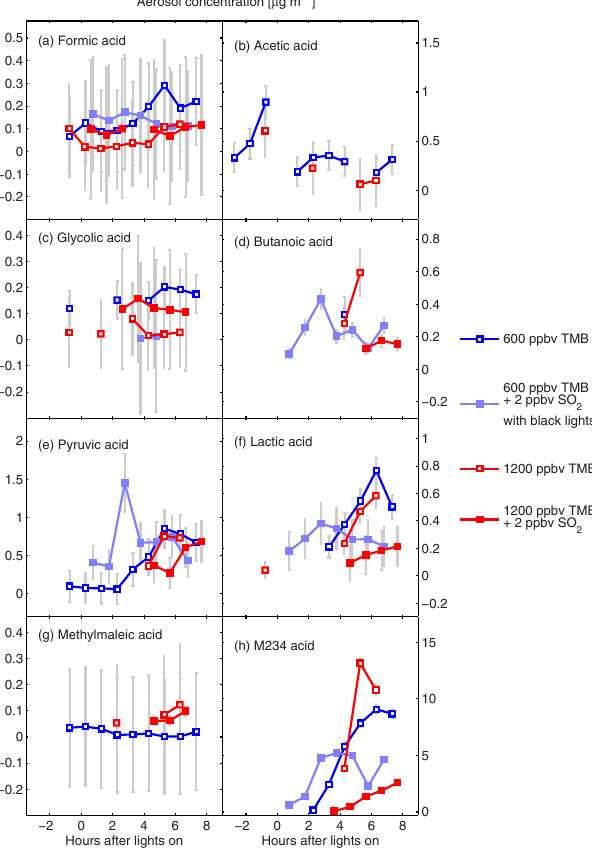
Figure 7. Aerosol concentration profiles (in µgm − 3 ) of eight mea- sured organic acids. See Fig. 6 for symbol